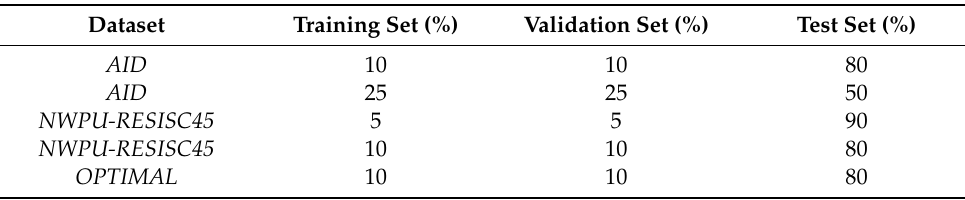
Table 2. Partition ratio of the datasets.